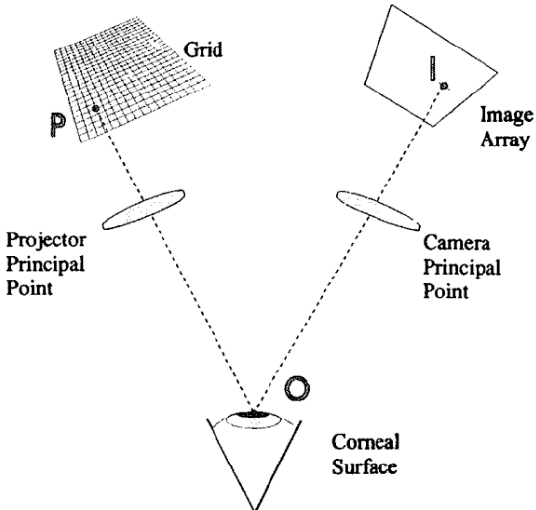
Figure 4. Triangulation principle for corneal surface measurement [48].